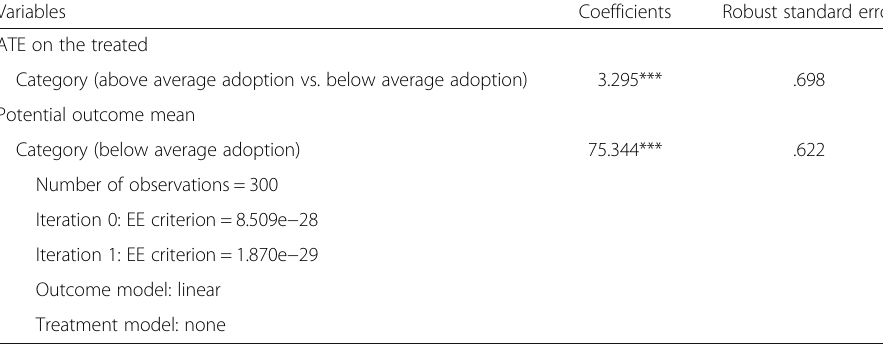
Table 6 Average treatment effect on the treated (ATET) Variables Coefficients Robust standard error ATE on the treated Category (above average adoption vs. below average adoption) 3.295*** .698 Potential outcome mean Category (below average adoption) 75.344***